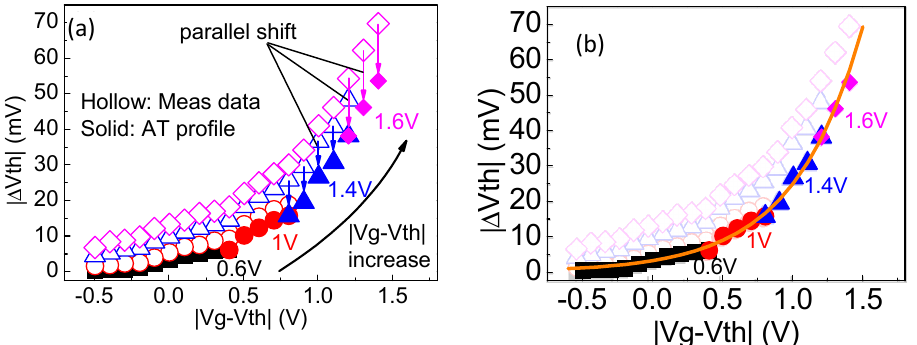
Figure 16. Presence of EADs: after charging, the electron energy level of the EADs rise, so that they cannot be discharged at the same energy level, resulting in the hysteresis [53].